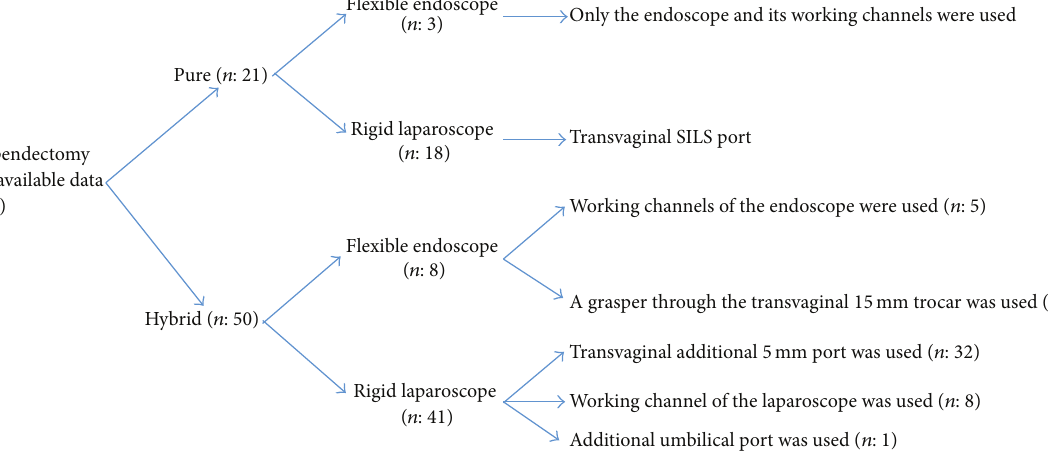
Figure 2: Technical details of the available transvaginal appendectomies.